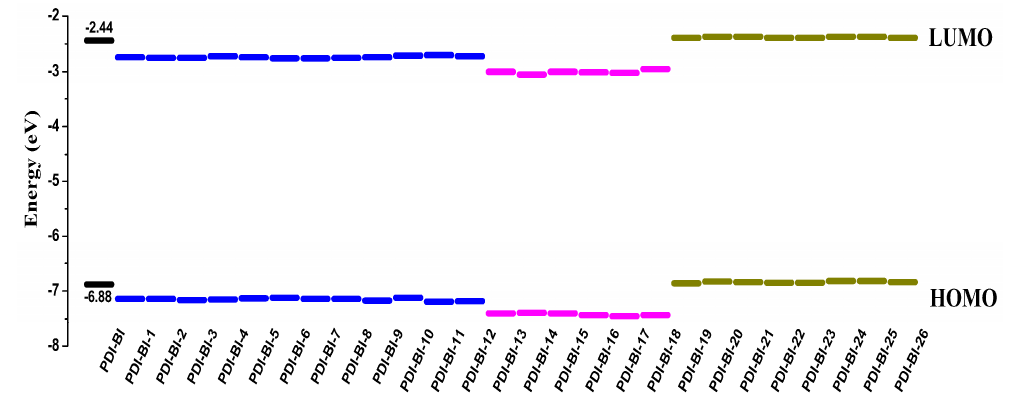
Figure 2. The distribution patterns of FMO for PDI-BI and its derivatives at the CAM-B3LYP/6-31G(d) level.